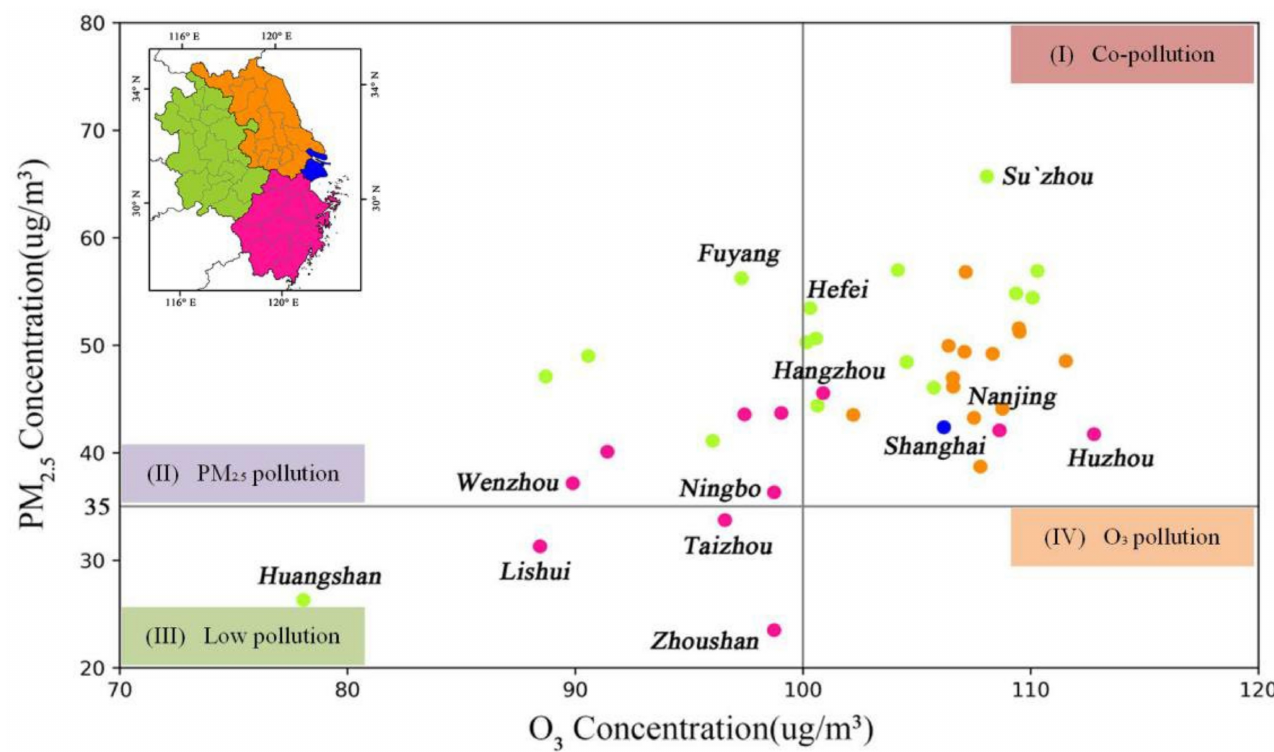
Figure 9. Classification of basic pollution types in cities of the YRD. According to the annual average PM 2.5 and O 3 _MDA8 concentrations from 2016 to 2019, the basic pollution types of these cities are divided into PM 2.5 pollution, O 3 pollution, co-pollution, and low pollution, according to the standard of T (PM 2.5 ) = 35 µ g/m 3 and T (O 3 ) = 100 µ g/m 3